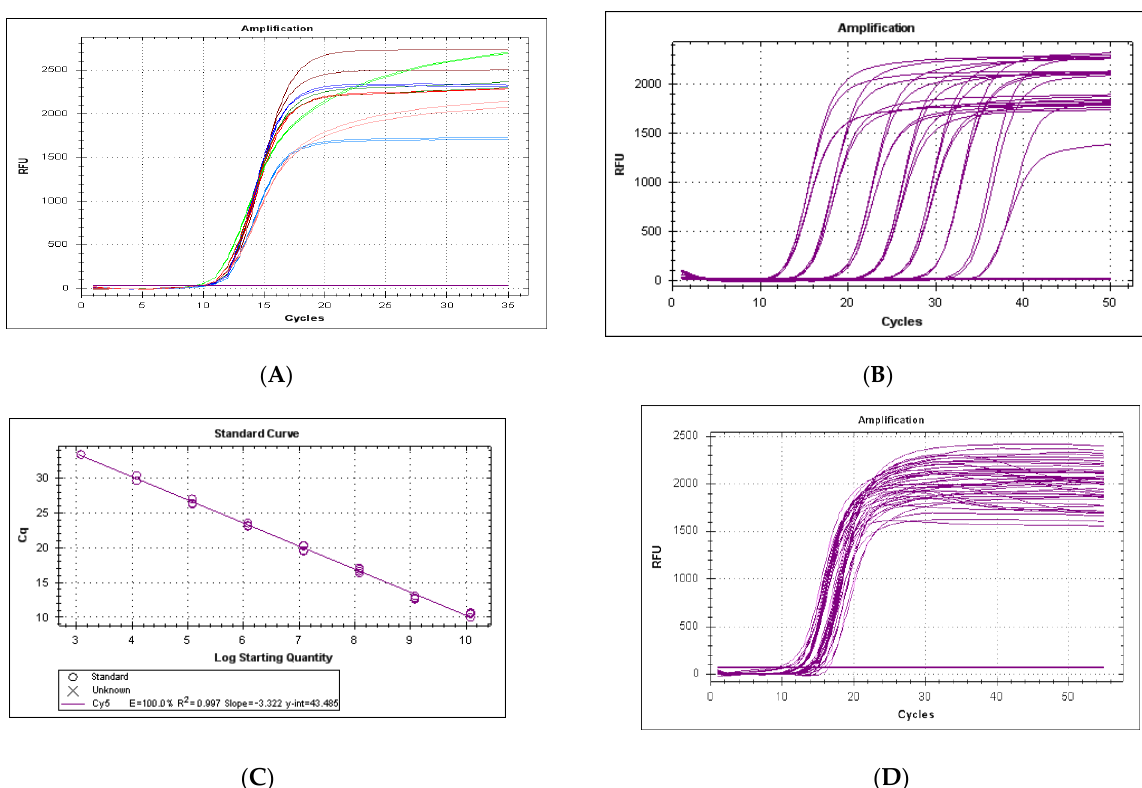
Figure 3. ( A ) Analysis of different primer concentrations for 18S DNA amplification. Fixed final concentration of the probe